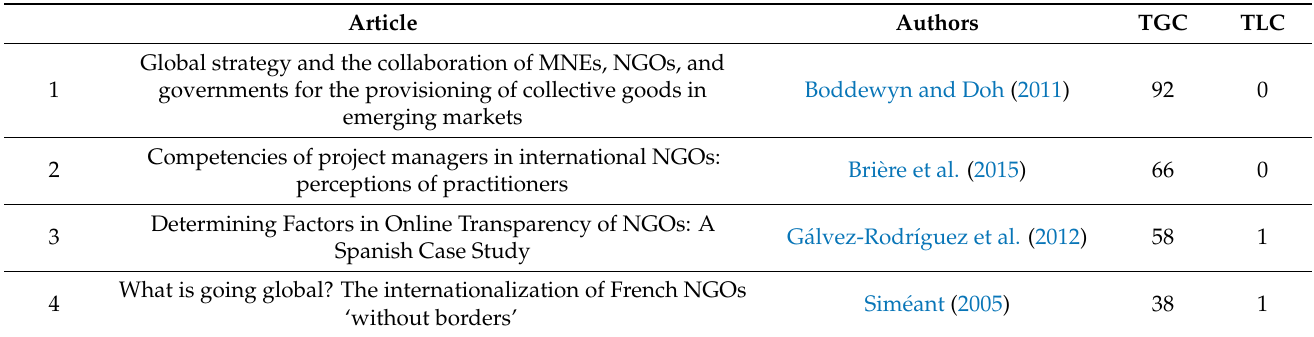
Table 3. Ranking of the articles based on TGC and TLC